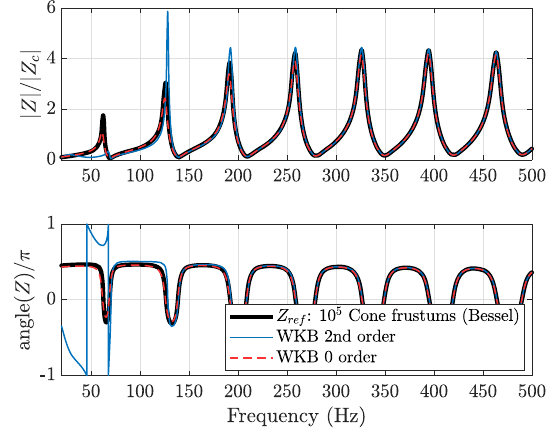
Figure 5. Input impedance of the simpli fi ed bassoon (reference impedance) compared with the WKB formulation on one conical frustums at the second and zeroth order (in both WKB solutions, the second order order is used for the Stokes